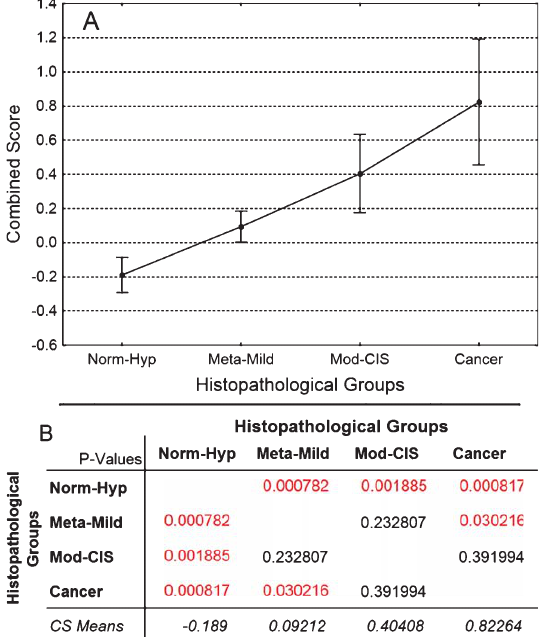
Fig. 2. Analysis of Combined Scores for samples from patients in each of the four histopathological groups created by combining similargrades:normal/hyperplasia,metaplasia/milddysplasia,mod- erate dysplasia to CIS, invasive cancer. A: Plot of mean CS. Error bars denote 95% confidence intervals. B: Summary P -value matrix of Tukey Unequal N HSD Post Hoc analysis. Significant P -values ( p <0.05) are highlighted in red and the italicized row shows mean Combined Scores in each group.